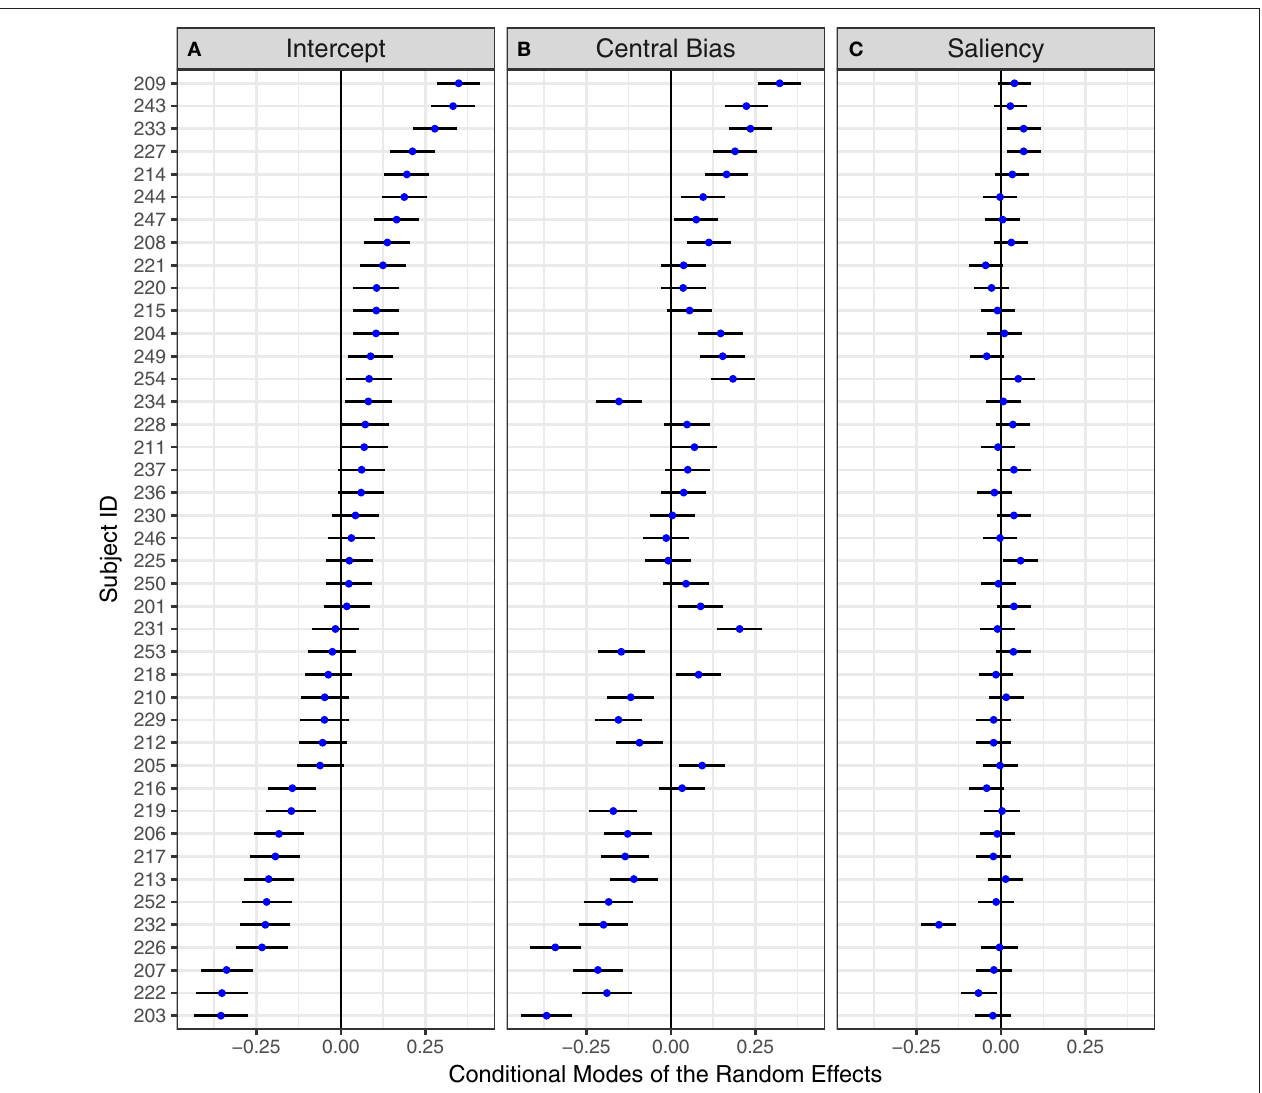
FIGURE 6 | By-subject random effects for the Central-Bias—Saliency GLMM testing Adaptive Whitening Saliency. “Caterpillar plots” for conditional modes and 95% prediction intervals of 42 subjects for (A) mean fixation probability, (B) central-bias effect, and (C) saliency effect. Subjects are ordered by (A) . The numbers on the y-axis are the subject